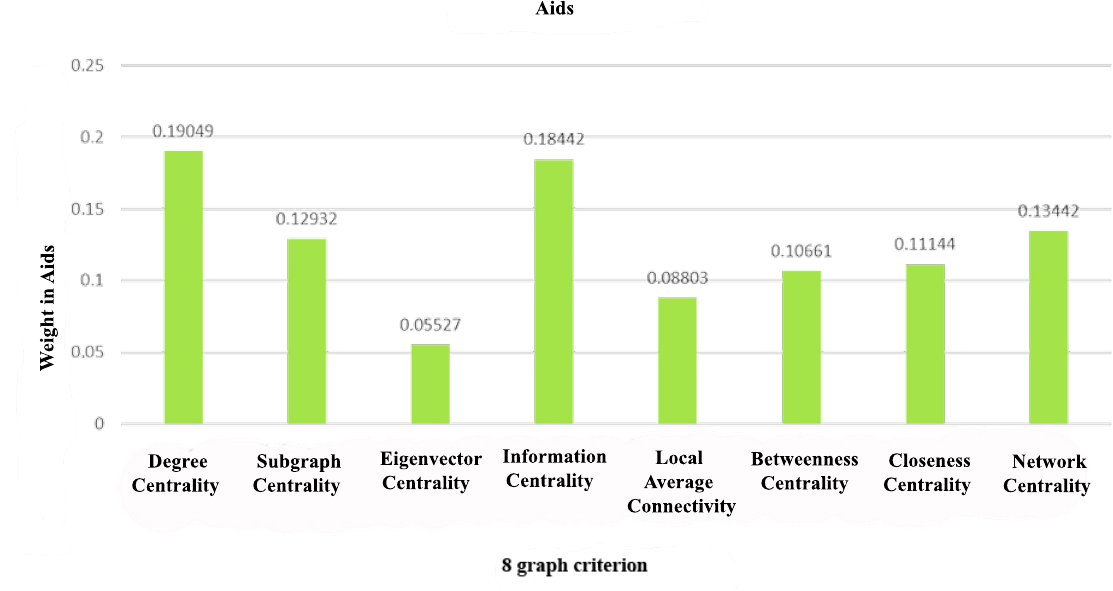
Figure 7. The average weighting of each criterion in the calculation of the important-score criterion by performing a 10-fold cross-validation on the DINGA system in the AIDS dataset.